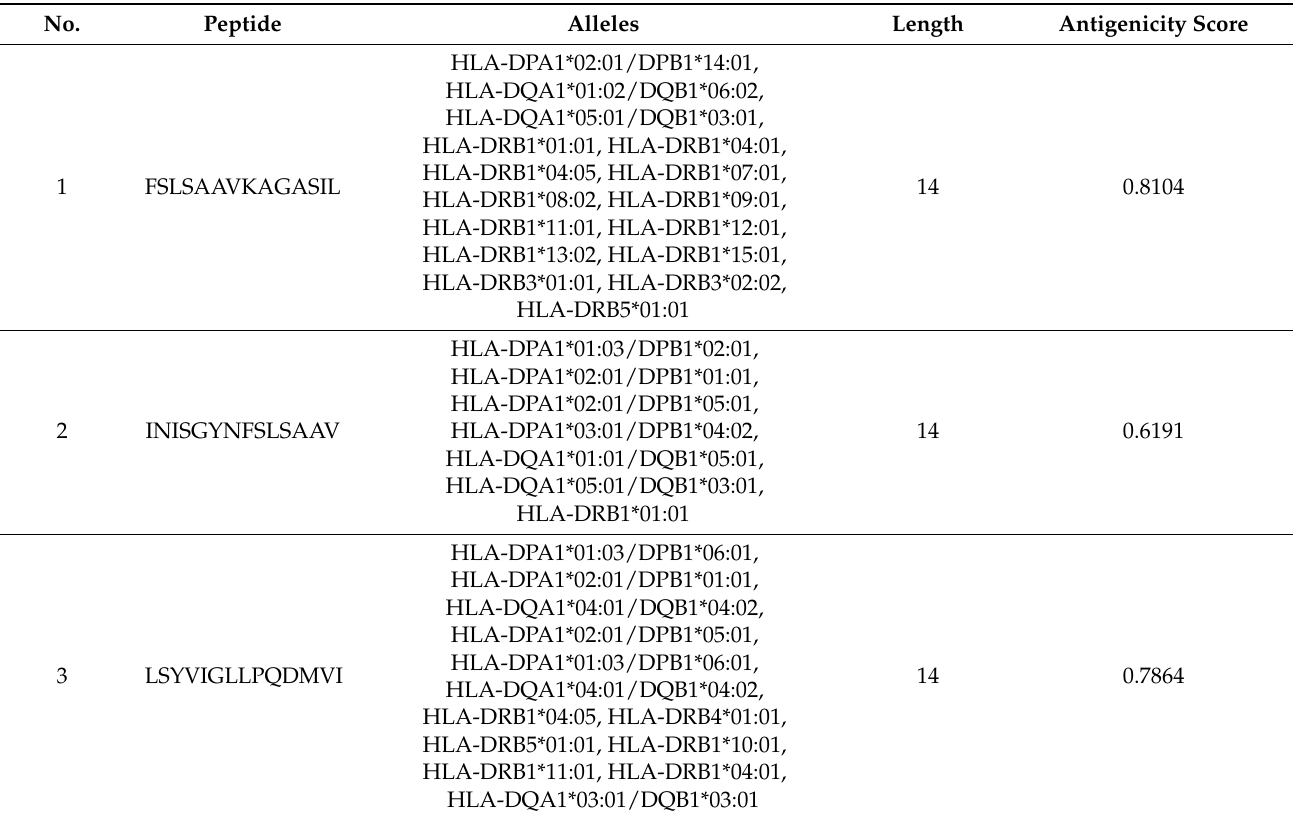
Table 3. Predicted MHC-II restricted epitopes computed from